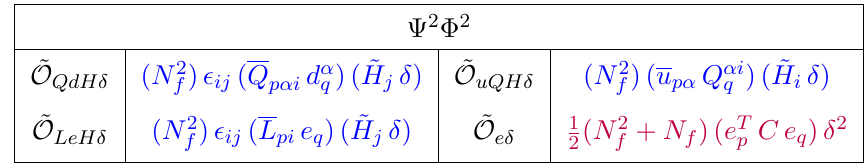
Table 3 . SM extended by Singly Charged Scalar ( δ ): additional operators of dimension 5. δ , δ † represent δ + and δ − respectively. Here i, j and α are the SU(2) and SU(3) indices respectively. p, q = 1 , 2 , · · · , N f are the flavour indices. The operator in red violates lepton number. Features of the additional